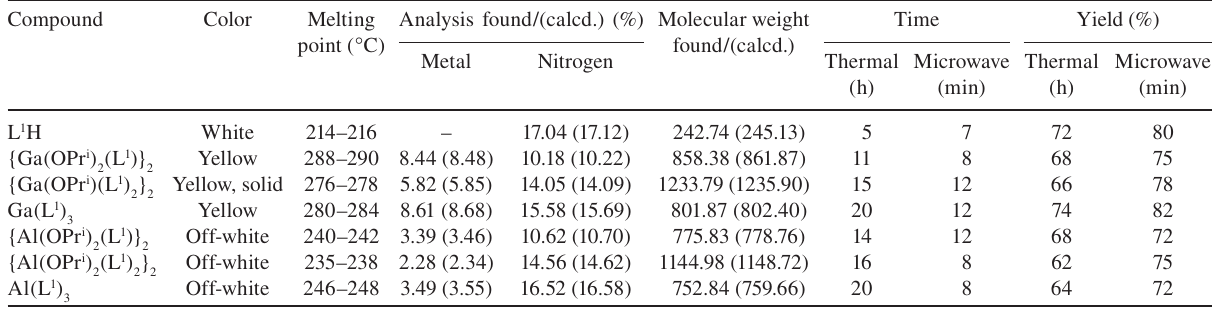
Table 3 Comparison between conventional and microwave method of synthesis, and physical properties and analytical data for L 1 H and its metal